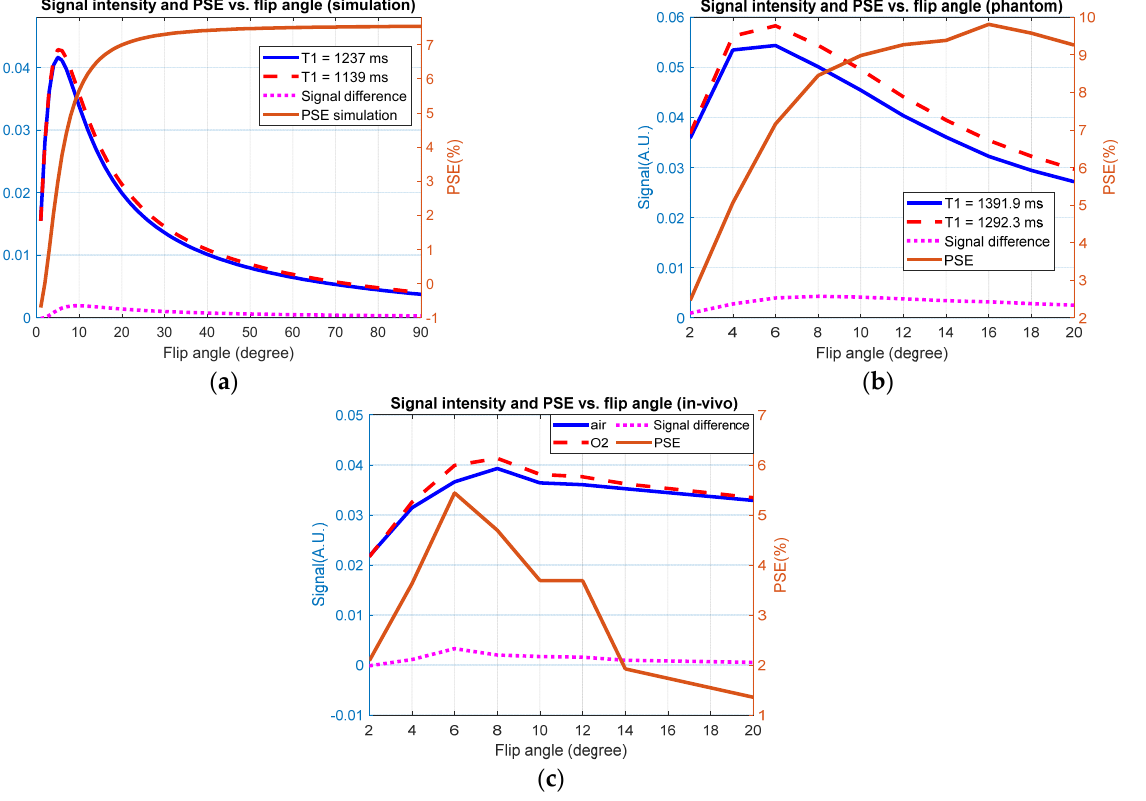
Figure 5. Signal intensity and PSE with variable flip angle: ( a ) Bloch simulation using T1/T2* reported in previous literature. ( b ) Experiment results with homemade T1 phantoms. ( c ) Experiment results on a healthy human. All PSE was calculated by Equation (1).